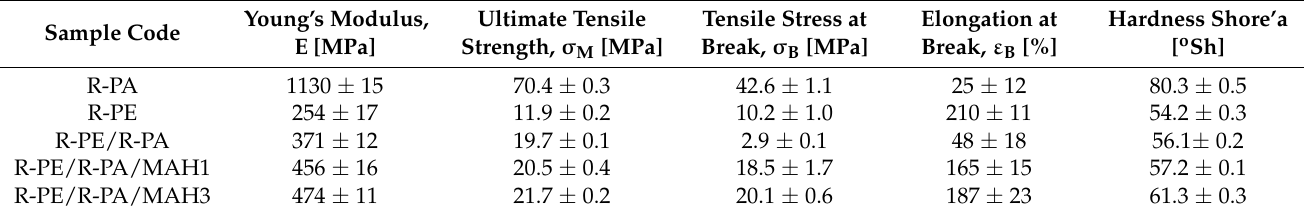
Table 6. Results of mechanical